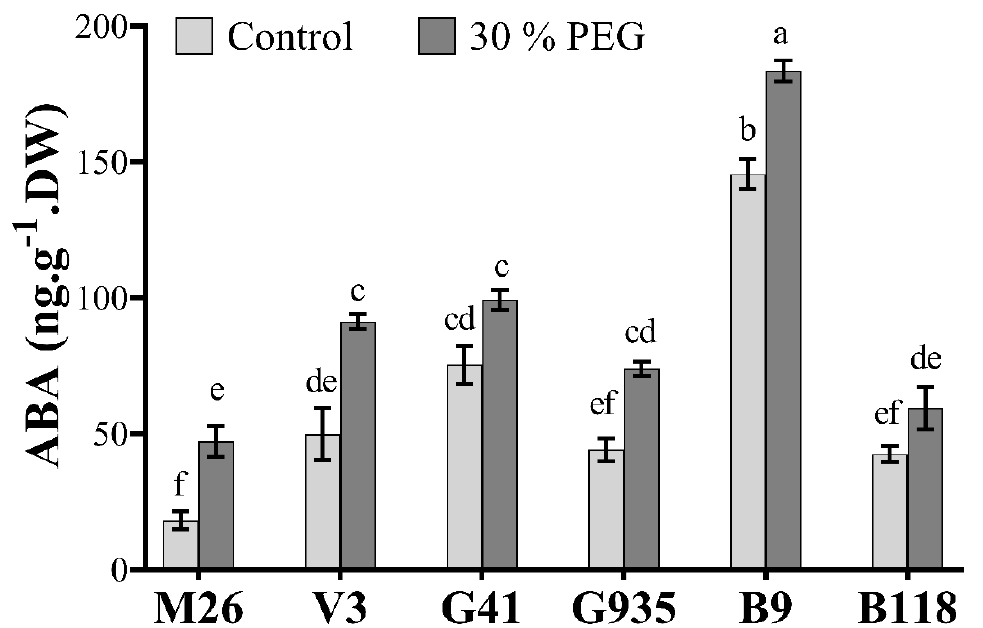
Figure 3. Evaluation of ABA levels in six apple rootstocks (M26, V3, G41, G935, B9 and B118) in control and PEG (30treatment. Means from all the treatments were compared with each other using Tukey’s test. Vertical bars represent the mean ± SEM of three biological replicates (three plants each). Bars with no common letters are significantly different (p < 0.05).